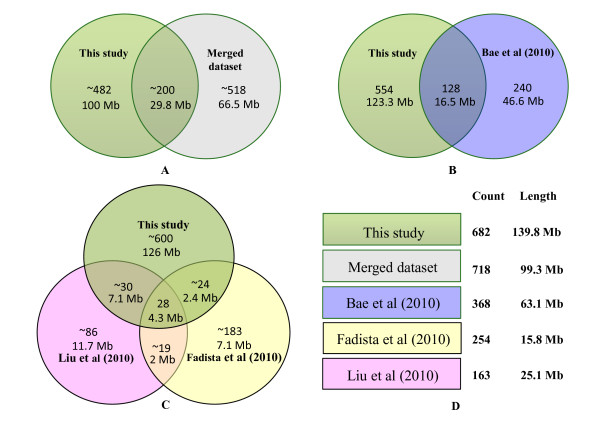
Comparisons between identified 682 CNVRs in this study and the other existing cattle CNVR datasets in terms of count and length. A, compared to the total nonredundant CNVR merged from existing published datasets; B, compared to CNVR derived from SNP array (Bae et al, 2010); C, compared to two CNVR datasets derived from array CGH studies (Liu et al,2010; Fadista et al, 2010); D, the summaries and legends of existing cattle CNVR datasets.